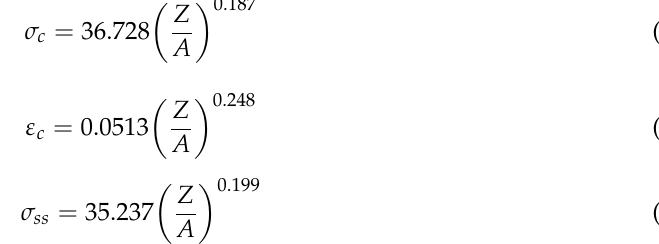
Figure 8. An example for identifying the values of σ ss and σ c through plotting θ vs. σ and d θ / d σ vs. σ (1373 K/0.01 s − 1 ) .